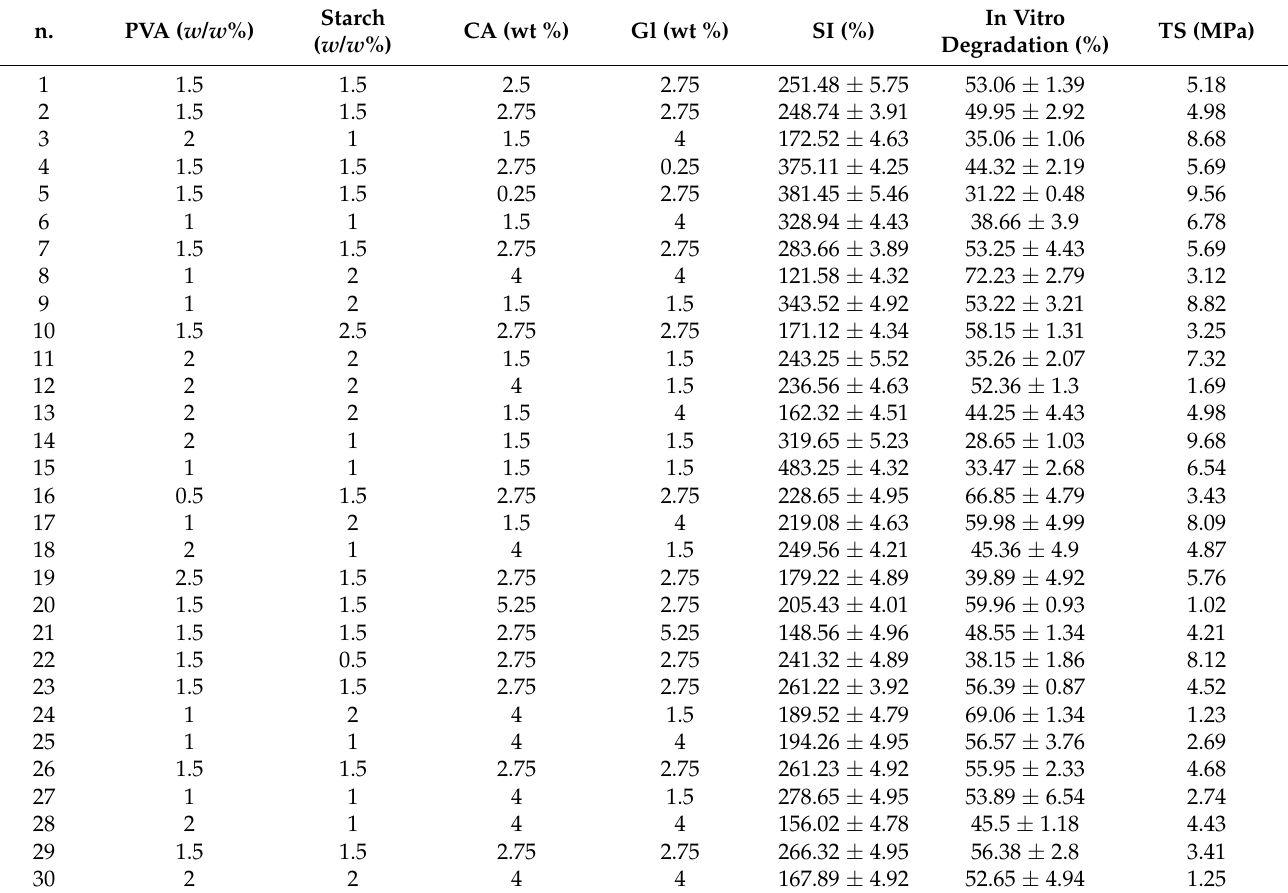
Table 1. Experimental data for central composite